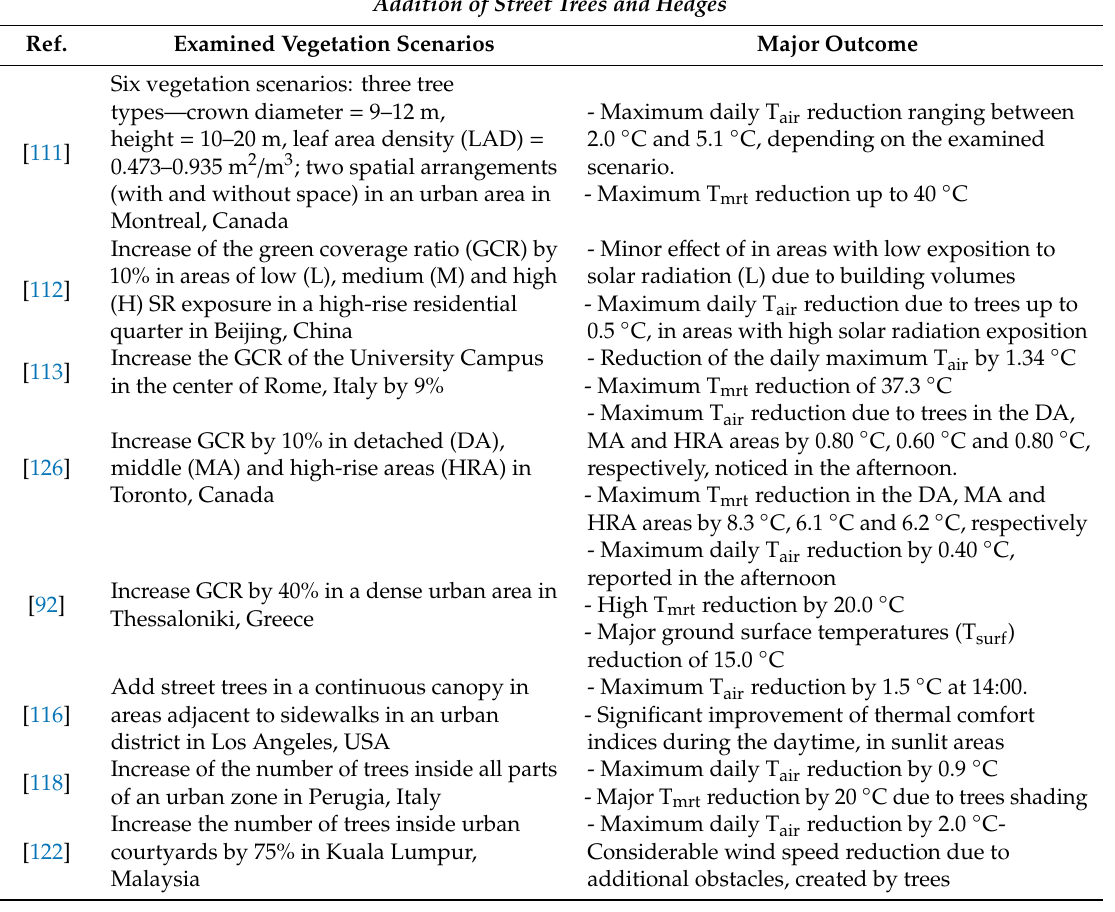
Table 2. Summary of previous studies, assessing the cooling potential of street trees. T air and T mrt simulation results refer to the pedestrians’ heights (i.e., 1.5–2.0 m from the ground